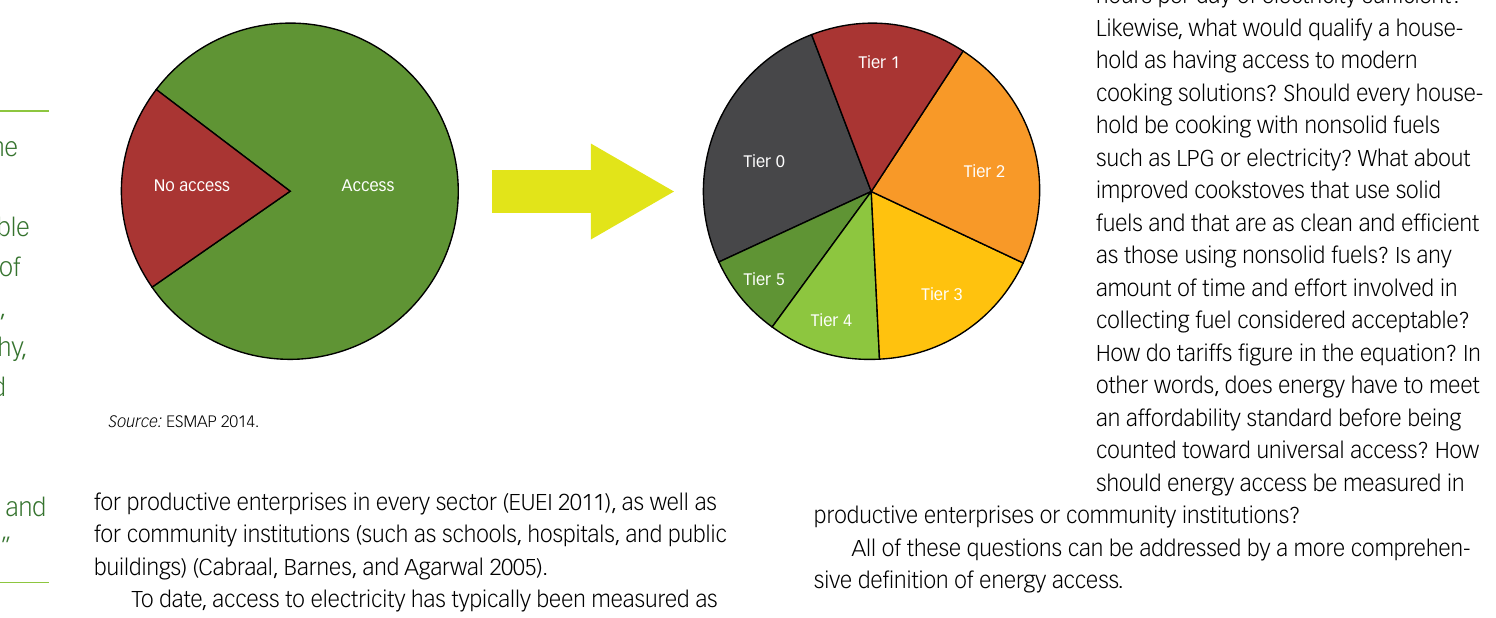
Figure 1. Binary versus multi-tier